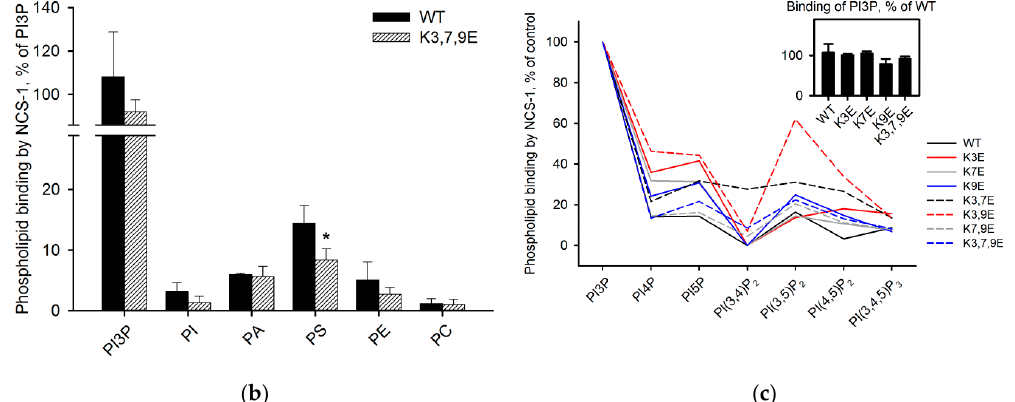
Figure 5. Binding of unmyristoylated Са 2+ -bound NCS-1 WT , its N-terminal mutants, and myristoylated NCS-1 WT to immobilized phospholipids determined using PIP-Strip TM assay. ( a ) Immunostained dot-blot membranes. Positions of lipid species are indicated in the left panel: 1— lysophospatidylcholine; 2—phosphatidylinositol (PI); 3—phosphatidylinositol-3-phosphate (PI3P);